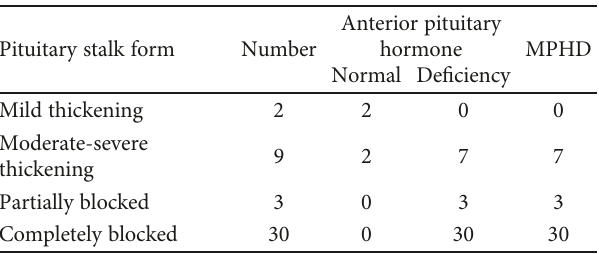
Table 5: Relationship of pituitary stalk abnormalities with anterior pituitary hormone secretion abnormalities.